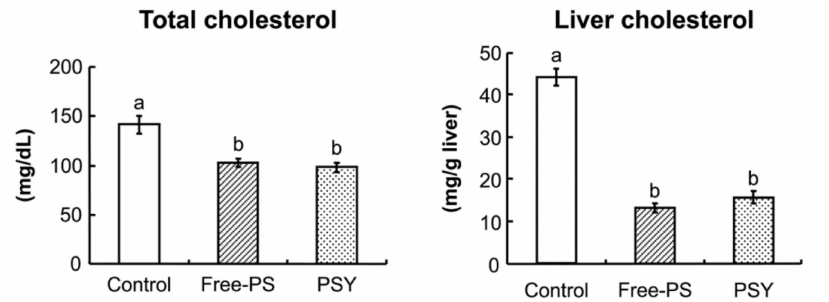
Figure 4. Cholesterol-lowering action of phytosterol egg yolk-lipoprotein complex in rat. Mean ± SE of six rats. Different letters shown significant difference ( p < 0.05). PS, phytosterols; PSY, phytosterol egg yolk-lipoprotein complex [15].